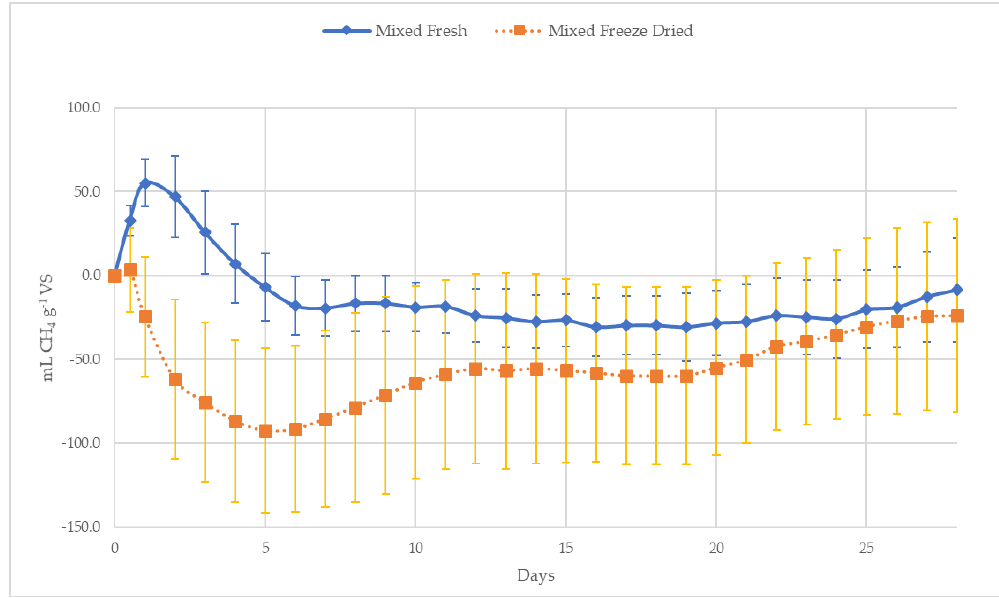
Figure 4. Net mean methane production from fresh and freeze-dried ‘Mixed Sargassum’ inundation samples from Turks and Caicos ( n = 4, error bars are standard deviation).